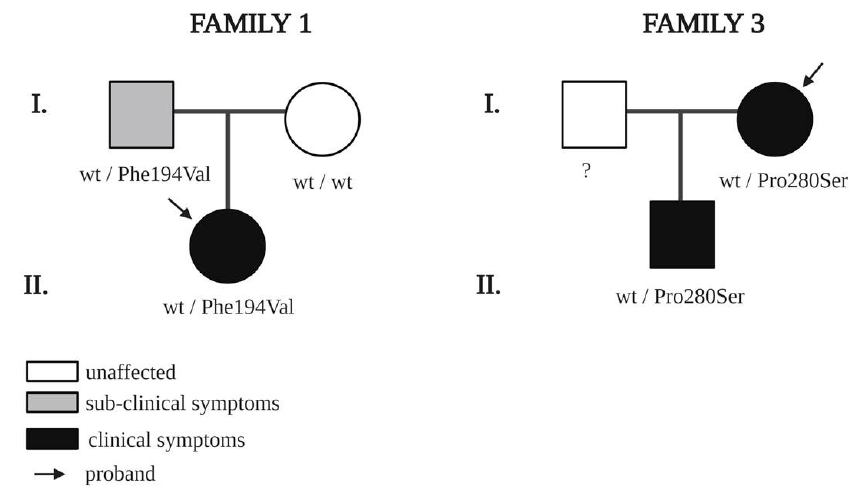
Figure 2. Pedigrees of families with rare NRP2 variants. Squares indicate males and circles, females; black indicates clinical symptoms of lymphedema; grey indicates subclinical symptoms confirmed by lymphoscintigraphy. Arrows indicate probands. ? means “not screened”, and wt indicates wildtype amino acid.